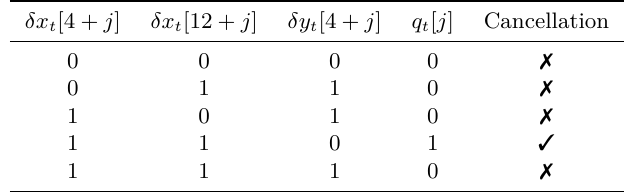
Table 6: All valid valuations of ( δx t [4 + j ] , δx t [12 + j ] , δy t [4 + j ] , q t [ j